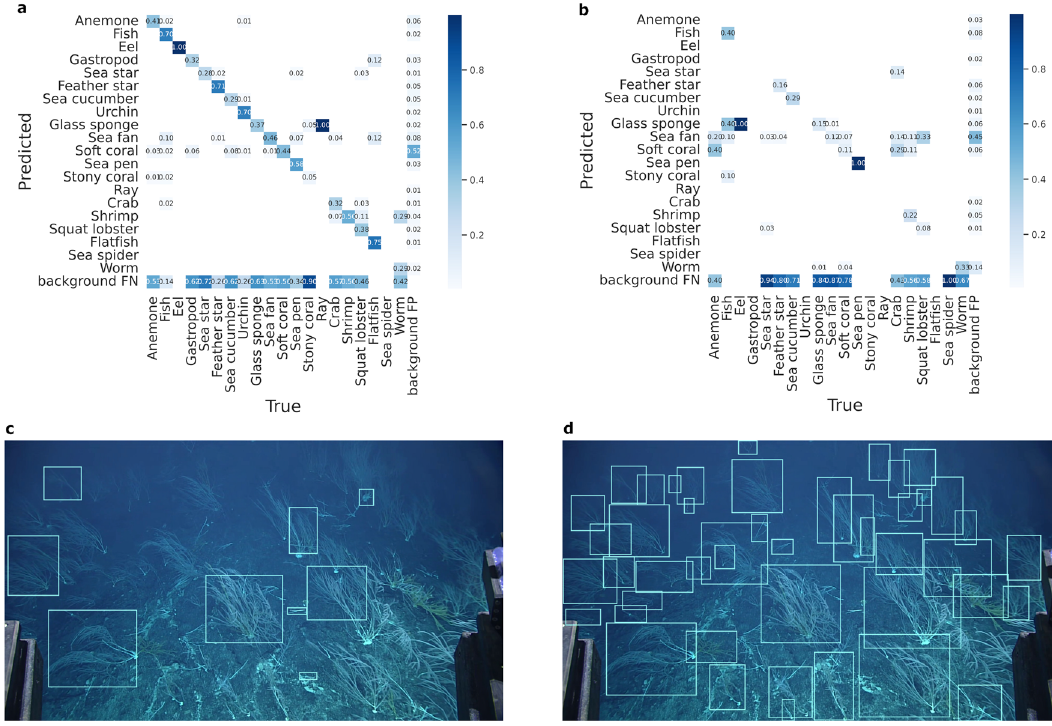
frame of NOAA video data. ( d ) Ground truth annotations for the same frame. Note the density, variability in coral morphology, and overlapping